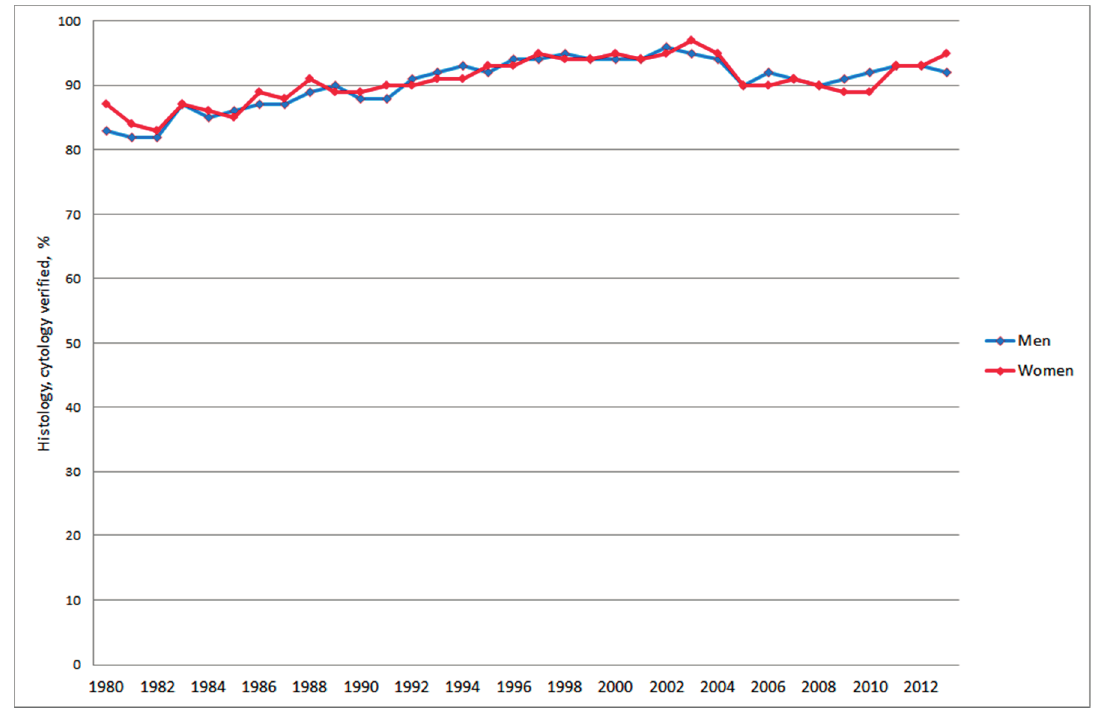
Figure 4. Frequency of nervous system tumours (ICD-7 code 193) confirmed with histology or cytology for all ages during 1980–2013 according to the Swedish Cancer